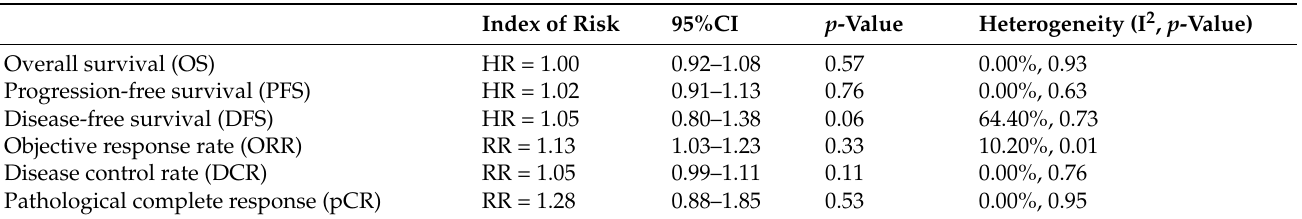
Table 1. The analysis results across all therapy approaches of celecoxib combined with cancer therapy for cancer